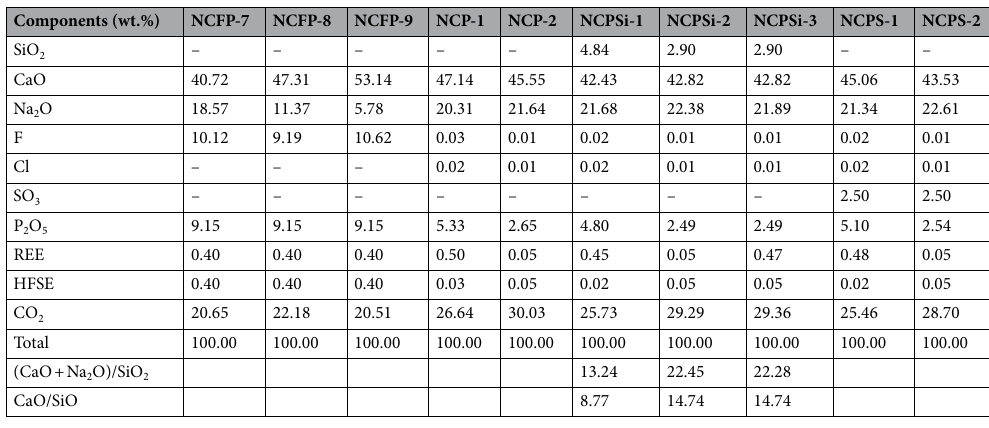
Table 1. Nominal major and trace compositions of starting mixtures (in